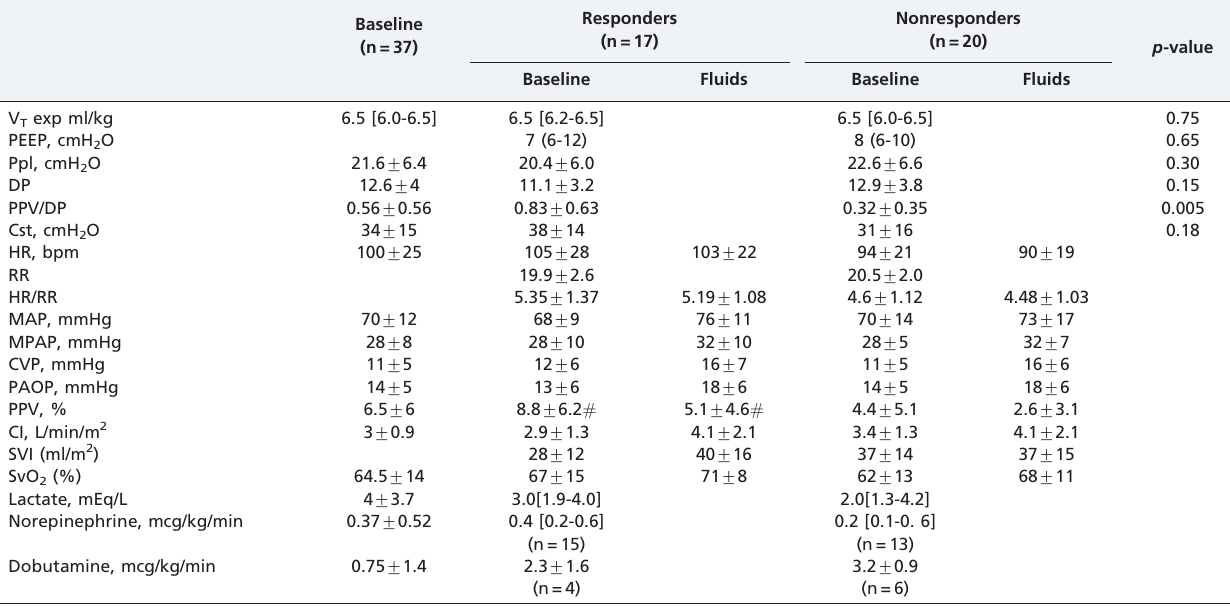
Table 2 - The hemodynamic and ventilatory data of responders and nonresponders.